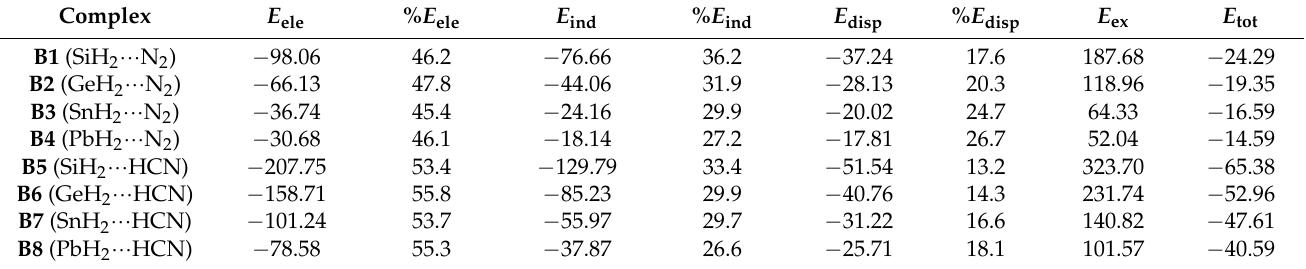
Table 6. Decomposition of the total interaction energy ( E tot ) for type-B complexes into electrostatic ( E ele ), induction ( E ind ), dispersion ( E disp ), and exchange ( E ex ) energy terms. All energies in kJ/mol. The relative values in percent represent the contribution of electrostatic, induction, and dispersion energy terms to the sum of all the three energy